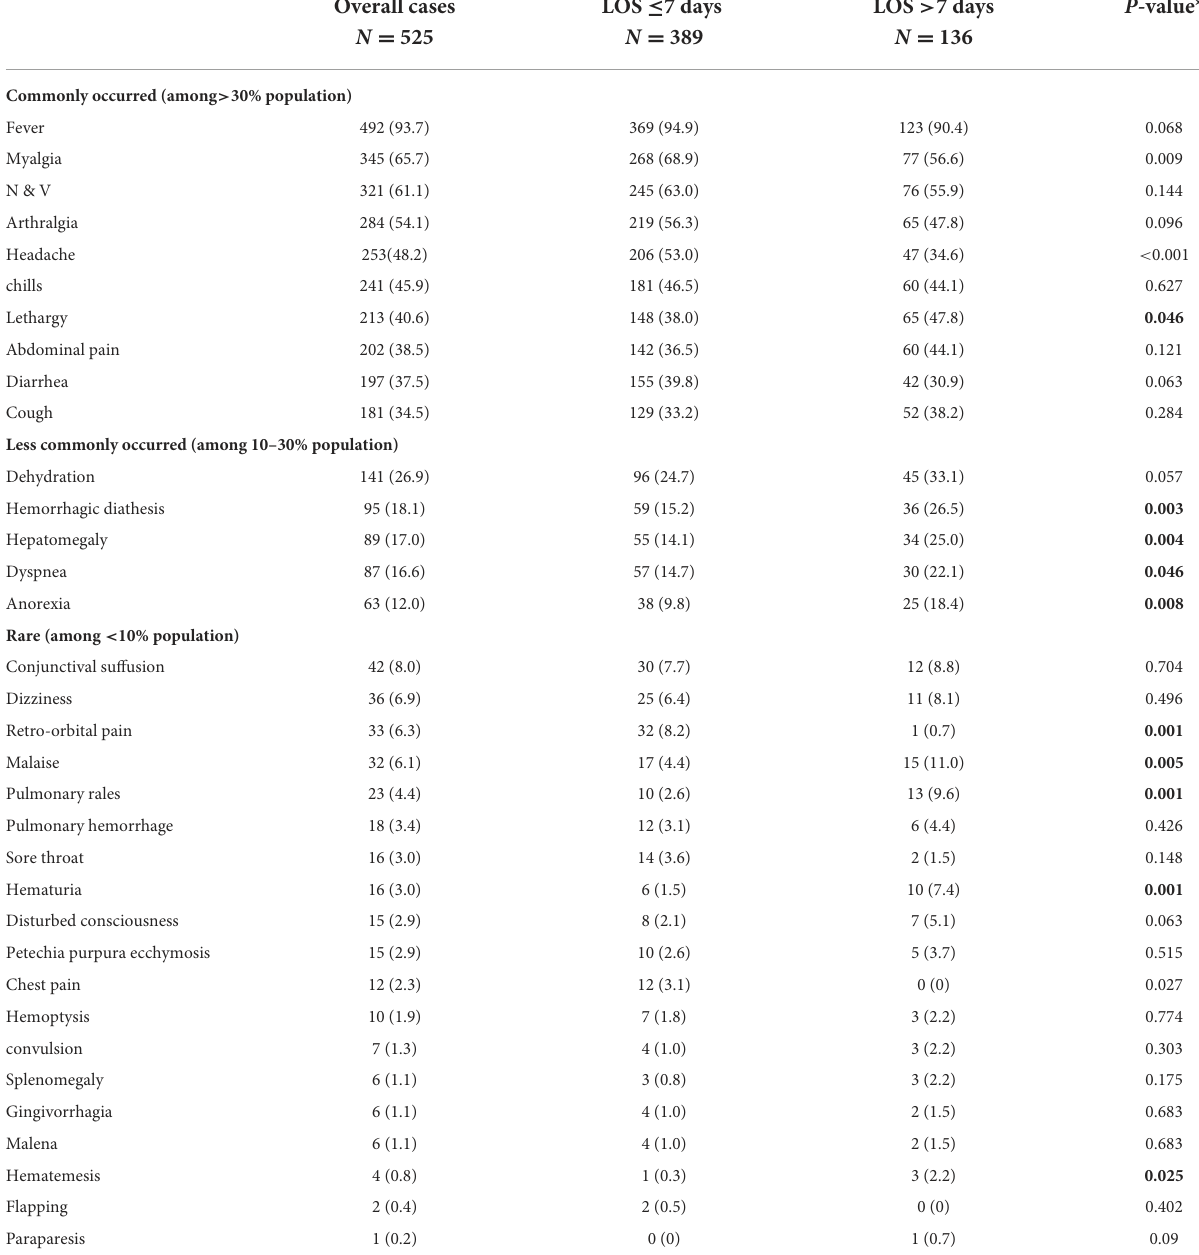
TABLE 2 Comparison of clinical manifestation (at baseline) between leptospirosis patients with and without prolonged hospitalization. Overall